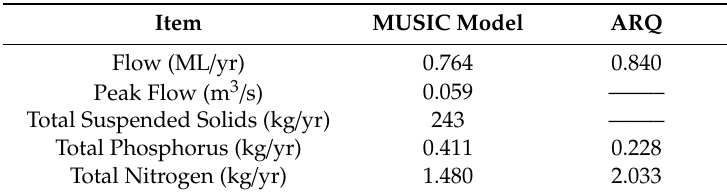
Table 1. Comparison of Model for Urban Stormwater Improvement Conceptualisation (MUSIC) model and Australian Runoff Quality Manual Guidelines (ARQ) results.